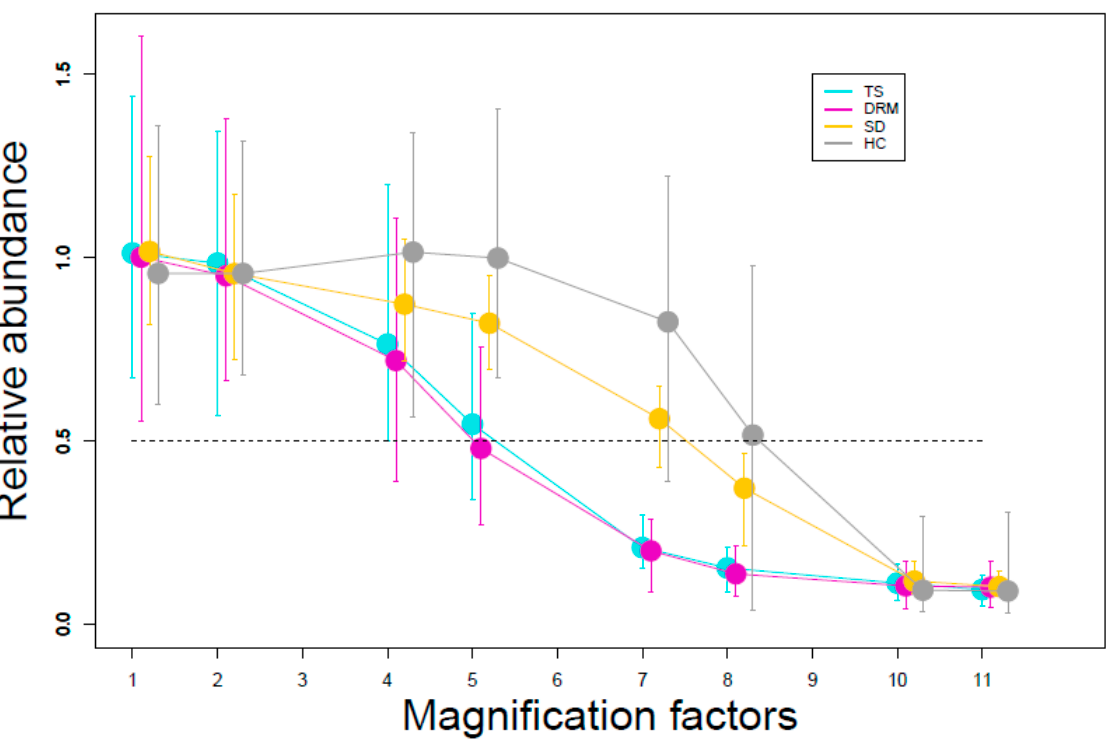
Figure 4. Relative population abundance for different magnification factors of the exposure profile shown in Figure 2. Average populations are calculated over exposure time (5 years), the ratios of over-time averages are calculated for each replicate, and then ratios are averaged over 40 replicates. The bars show the maximum and minimum value of the ratio among the 40 replicates. Symbols and bars are shifted for visual reason. TS: Topeka shiner; DRM: Devils River minnow; SD: Spikedace; HC: Humpback chub.